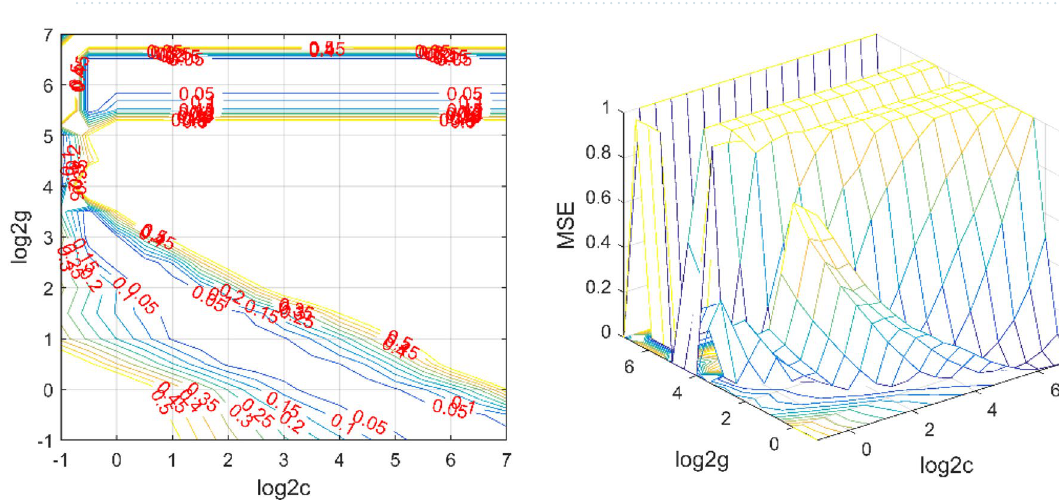
Figure 7. The K-CV statistical analysis method learns training samples. The SVR parameter selection result map (contour map) is seen on the left. The SVR parameter selection result graph (3D view) is seen on the